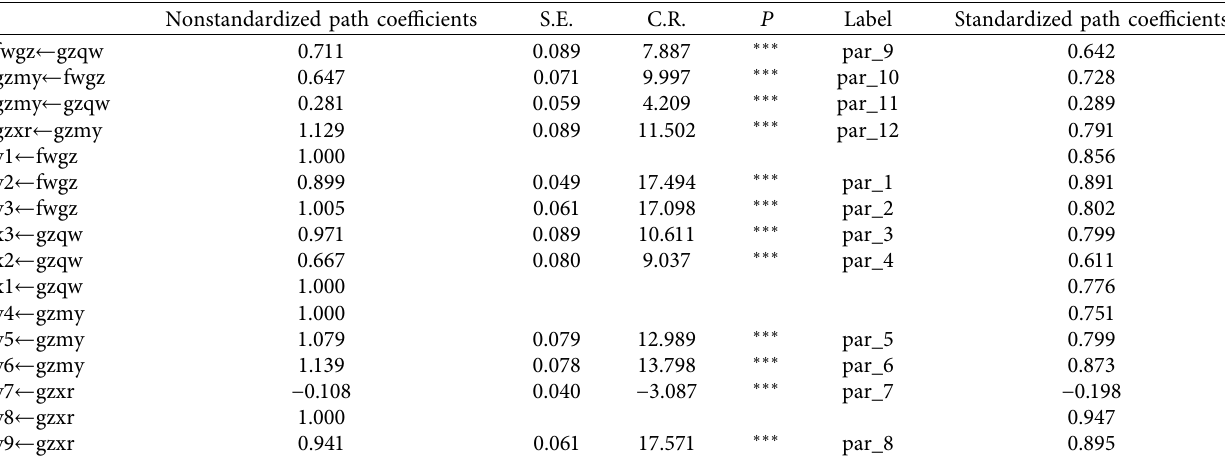
Table 3: Statistical estimates of path coefficients.